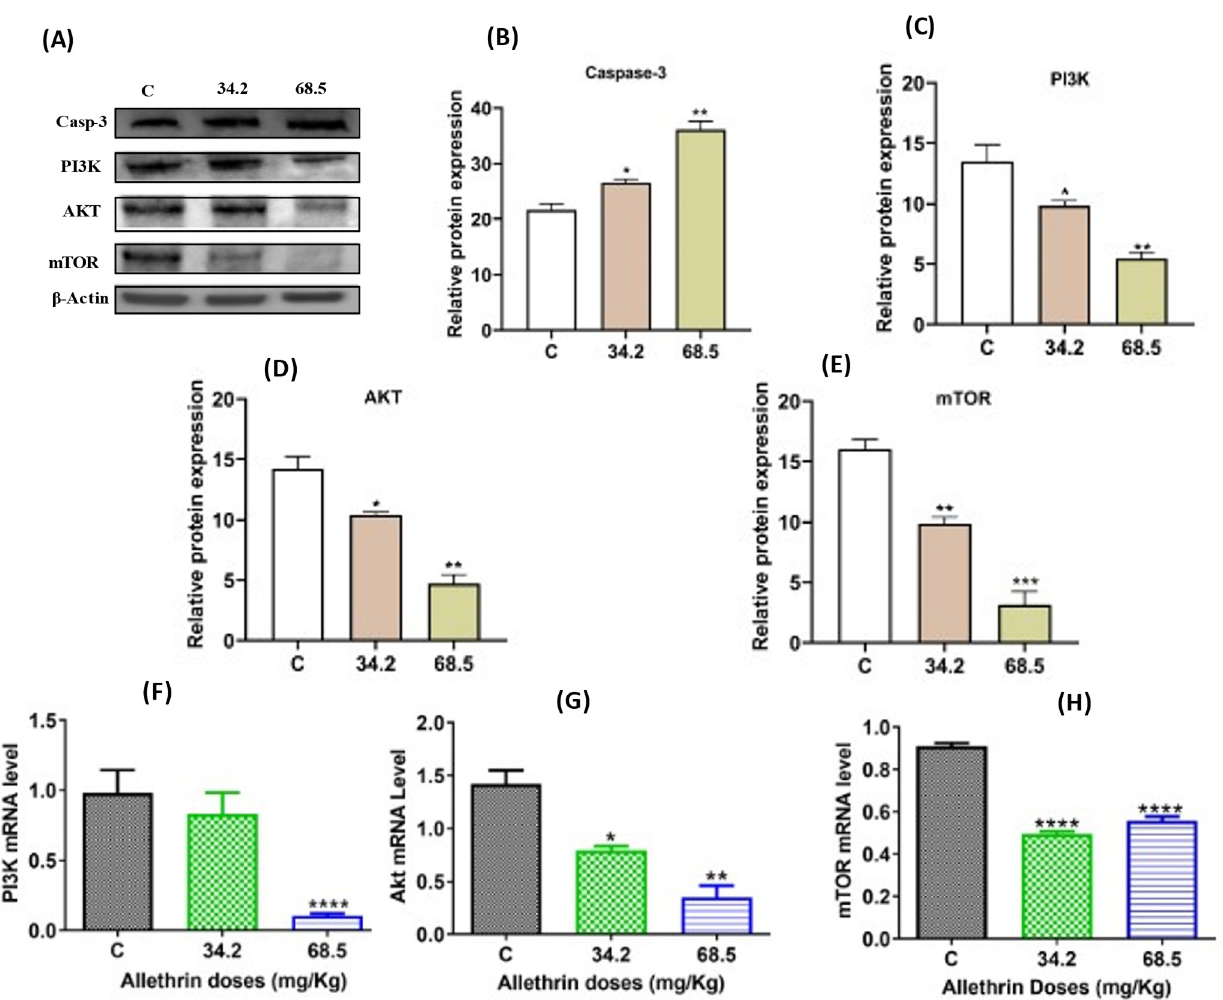
Figure 5. Effects of allethrin on the expression of apoptosis and autophagy markers at the protein and mRNA levels in the rat ovaries ( A – E ). The protein expression levels of active caspase-3, PI3K, AKT and mTOR were examined by western blotting. The mRNA expression levels of the genes encoding PI3K, AKT and mTOR were detected by RT–PCR ( F – H ). All data are expressed as the means ± SDs. * p < 0.05; ** p < 0.005; *** p < 0.0001; **** p < 0.00001.